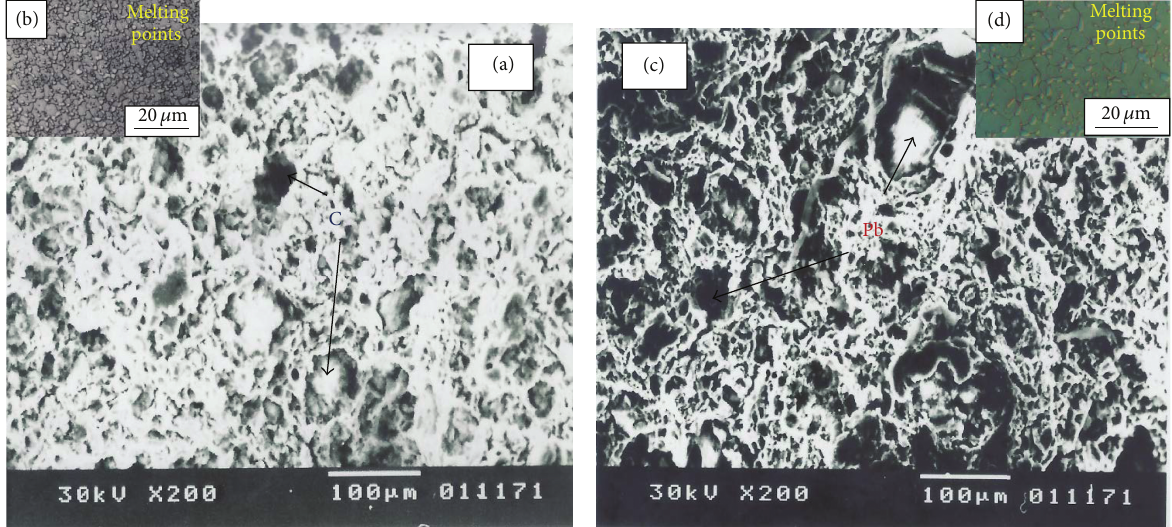
Figure 9: SEM image of irregularity and rough morphology of the fracture surface for (a) compression fractured 85% Cu-10% Sn-5% C alloys, (b) higher magnification showing melting droplets morphology, (c) compression fractured 80% Cu-10% Sn-10% Pb alloys, and (d) higher magnification showing melting droplets